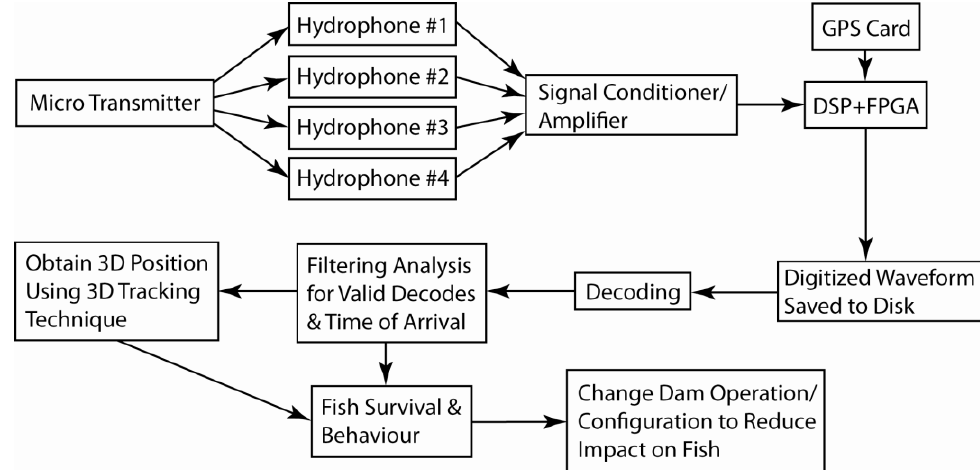
Figure 1. JSATS cabled system schematic showing main components and direction of signal acquisition and